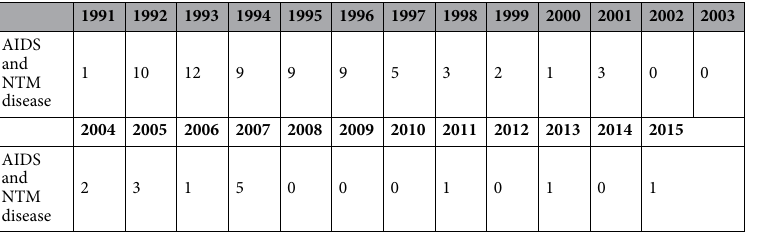
Table 5. Number of HIV-positive patients where nontuberculous mycobacteria are the AIDS-defining illness. AIDS: Acquired Immune Deficiency